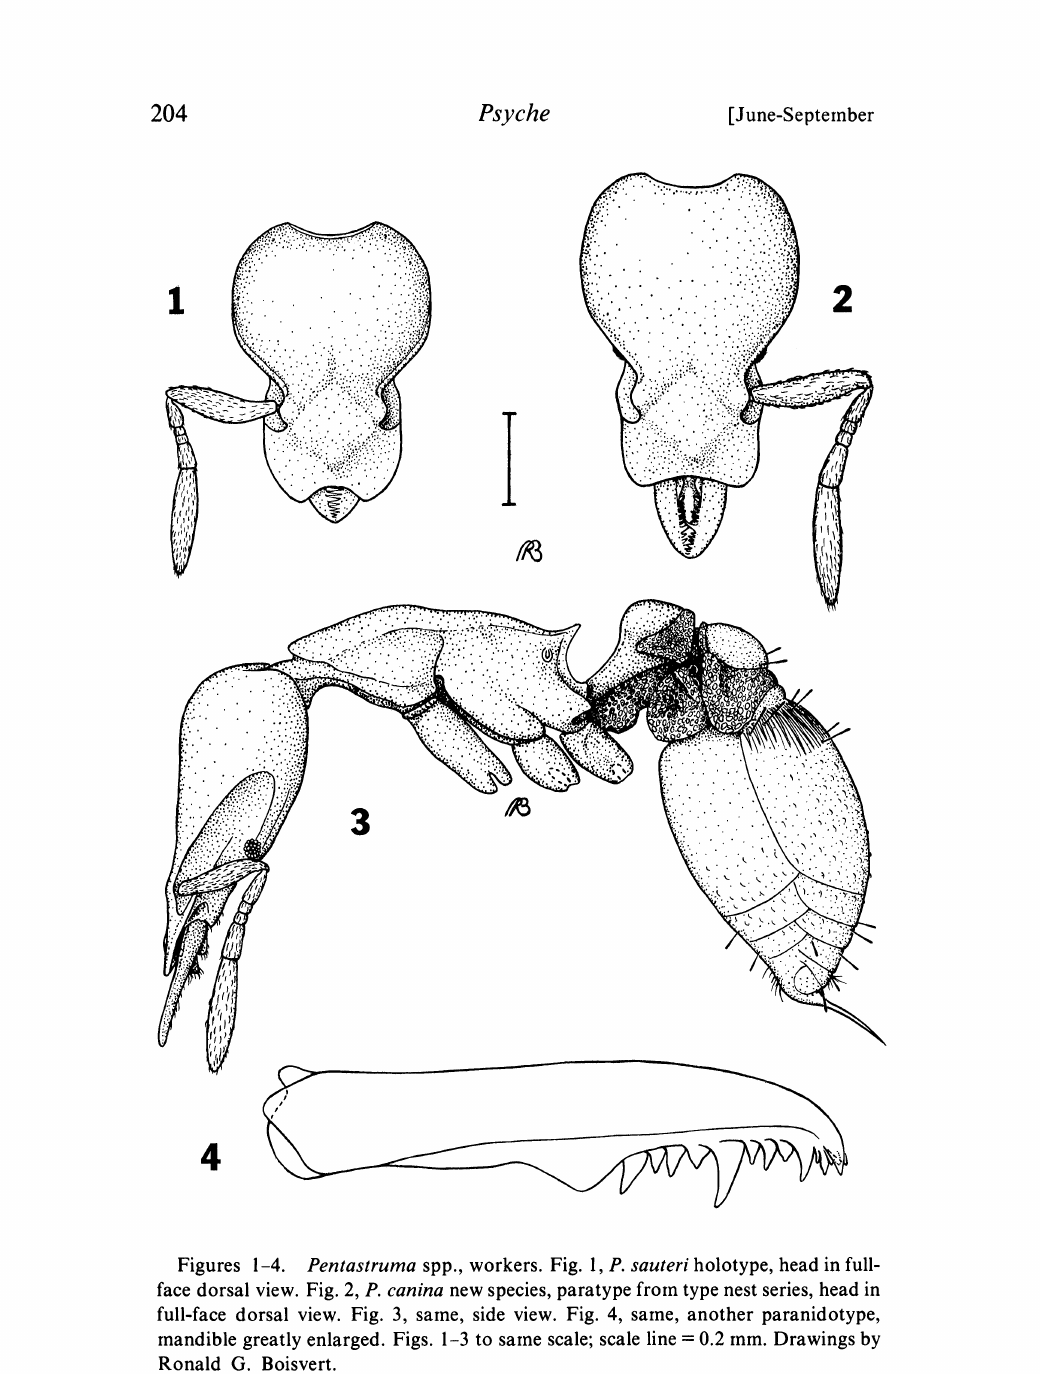
Figures 1-4. Pentastruma spp., workers. Fig. 1, P. sauteri holotype, head in full- face dorsal view. Fig. 2, P. canina new species, paratype frown type nest series, head in full-face dorsal view. Fig. 3, sa[ne, side view. Fig. 4, same, another paranidotype, mandible greatly enlarged. Figs. 1-3 to sane scale; scale line 0.2 [nrn. Drawings by Ronald G.